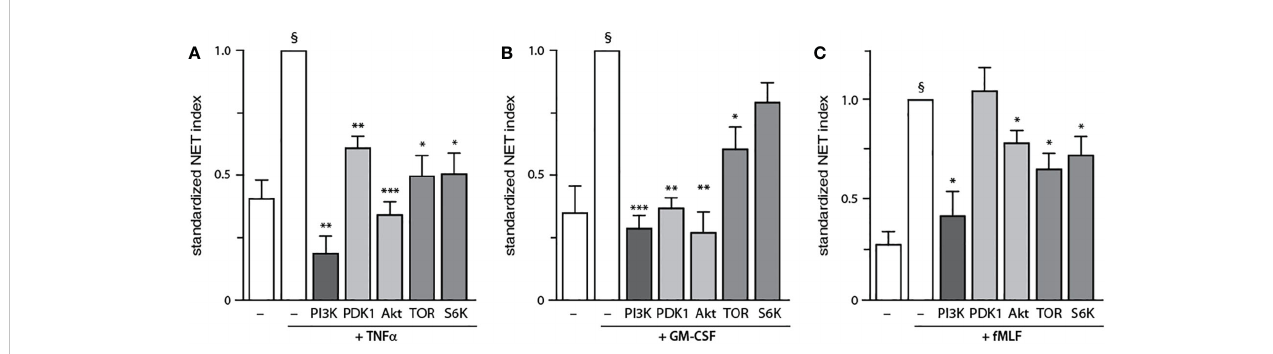
FIGURE 4 Discrete PI3K signaling partners drive NET formation depending on the stimulus. Neutrophils cultured on poly-L-lysine-coated coverslips were pre- treated (15 min, 37°C) with the following inhibitors or their diluent (0.1% DMSO): 10 m M LY294002 (PI3K inhibitor); 5 m M BX-912 (PDK1 inhibitor); 10 m M Akt inhibitor VIII (Akt inhibitor); 100 nM rapamycin (mTOR inhibitor); or 10 m M PF-4708671 (S6K inhibitor). The cells were then stimulated or not for 4 h at 37°C with (A) 100 U/ml TNF a , (B) 1 nM GM-CSF, or (C) 100 nM fMLF. NET formation was assessed using PlaNET Green as described in Methods . Mean ±